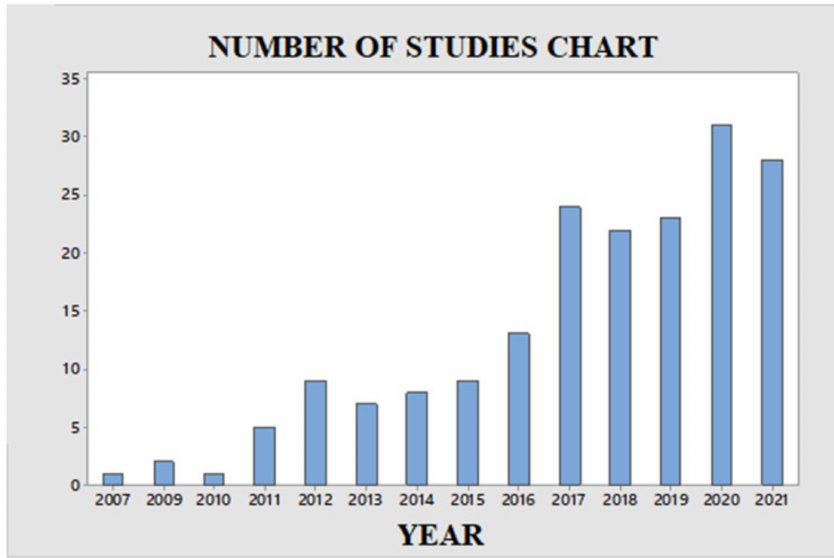
Figure 4. Journal search results (Number of studies